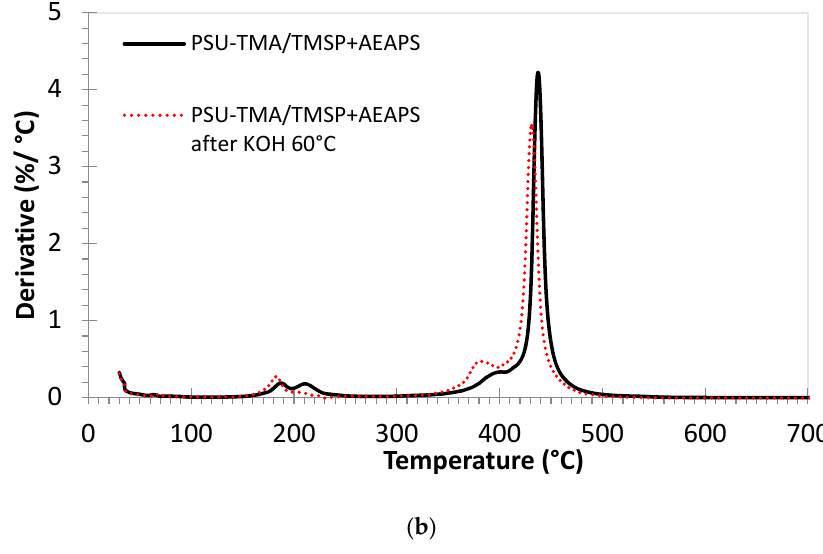
Figure 4. Thermogravimetric analysis of membranes in Cl form under air (mass loss and derivative curves). ( a ) PSU-TMA/TMSP, ( b ) PSU-TMA/TMSP+AEAPS. Red curves: after 24 h in KOH at 60 °C.